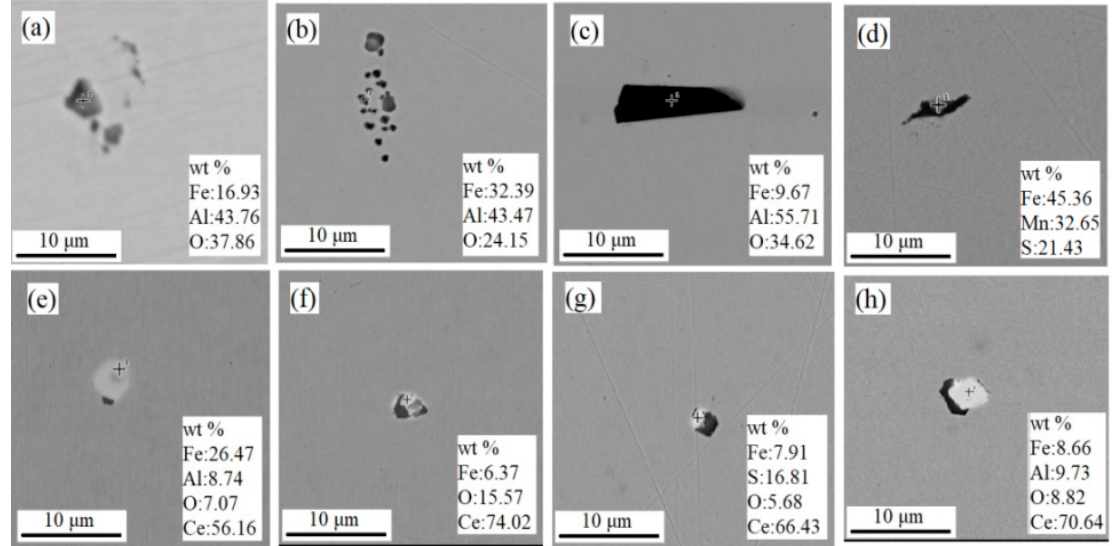
Figure 5. Comparison of typical inclusion morphology between the samples 1# and 2# in each process. 1#: ( a ) CC, ( b ) HR, ( c ) CR, ( d ) CA. 2#: ( e ) CC, ( f ) HR, ( g ) CR, ( h ) CA.